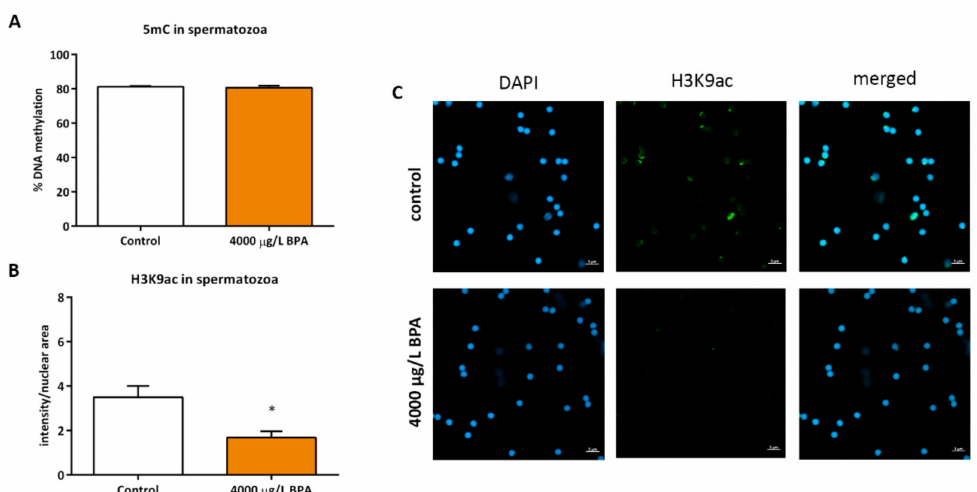
Figure 4. Epigenetic profile of spermatozoa. ( A ) bars represent the percentage of global DNA methylation in spermatozoa of 3 pools of sperm from 5 control and 5 exposed fish each ( n = 3). ( B ) bars represent the intensity of H3K9ac labelled with AlexaFluor ® 488 of 3 pools of sperm from 5 control and 5 exposed fish ( n = 3); asterisks indicate significant di ff erences ( p < 0.05) when compared to control males. ( C ) confocal images of H3K9ac in spermatic nuclei (stained with DAPI); scale bar 5 µ m.